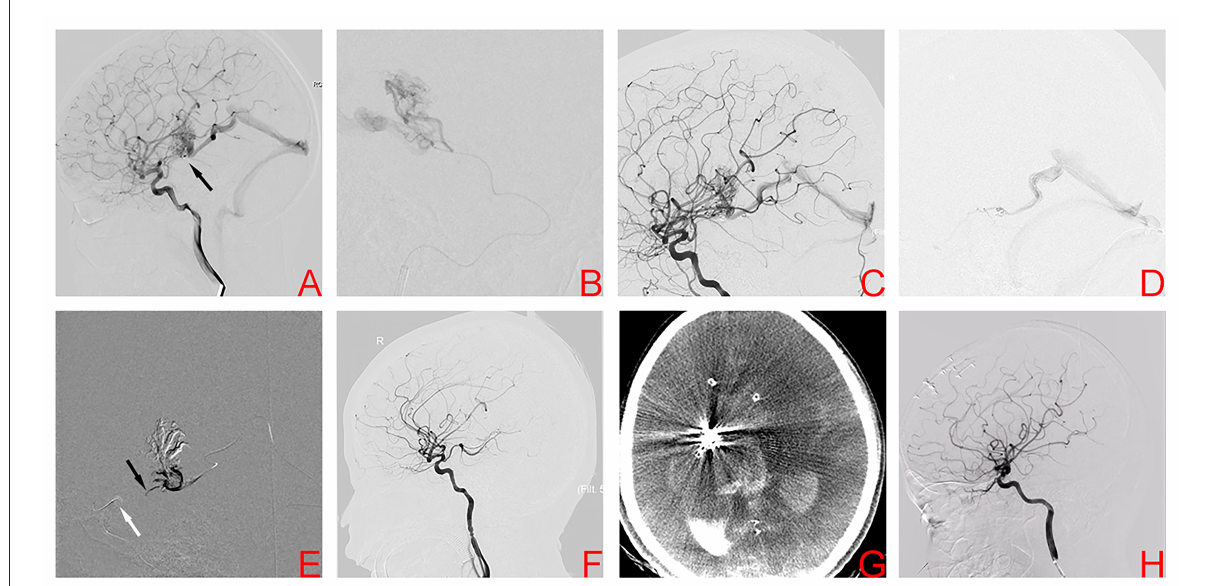
FIGURE2 Digital subtraction angiography demonstrates the right basal ganglia arteriovenous malformation in case 2 (A) . Superselective arteriography and embolization via the posterior communicating artery (B) . Angiography after transarterial embolization shows a partially embolized arteriovenous malformation (C) . TVE was performed due to the lack of optimal arterial access. Transvenous microcatheter injection angiography confirmed an optimal position of the microcatheter tip (D) . After the balloon (white arrow) was inflated to provisionally occlude the ipsilateral internal carotid artery, Onyx was injected transvenously into the AVM nidus through the microcatheter, and ∼ 2cm of embolysate reflux (black arrow) was encountered prior to achieving sufficient retrograde nidal penetration (E) . Postoperative angiography showed complete embolization (F) . However, postoperative CT confirmed intracranial hemorrhage (G) . Angiography 1 year later showed complete embolization of the arteriovenous malformation (H)